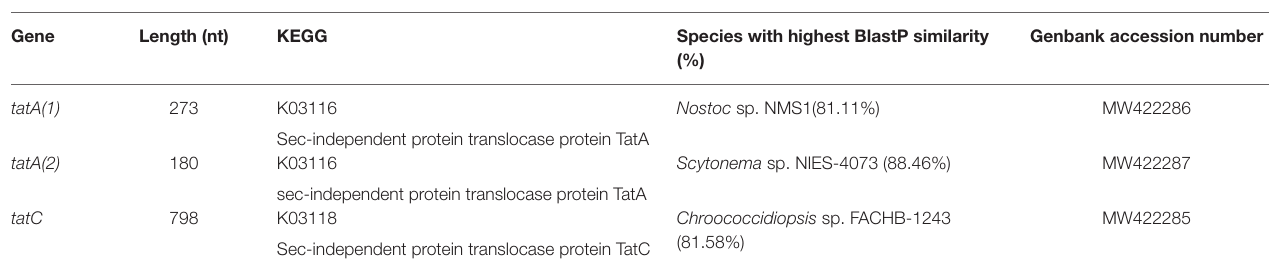
TABLE 3 | Tat system genes of Chroococcidiopsis sp. CCMEE 029.